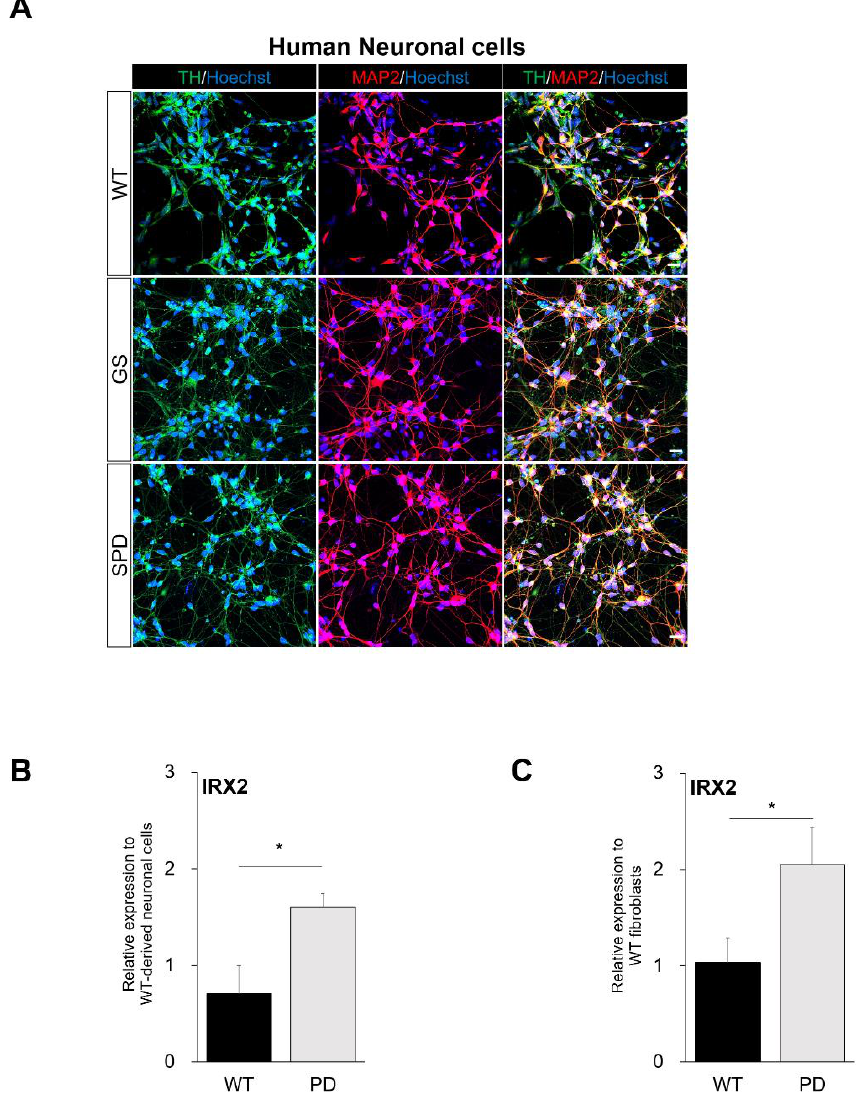
Figure 5. Confirmation of the expression of the newly identified gene, IRX2 , in neuronal cells containing dopaminergic neurons. ( A ) Characterization of neuronal cells containing dopaminergic neurons from healthy control (WT), LRRK2 G2019S familial (GS), and sporadic (SPD) PSCs. The neuronal marker (Microtubule-associatedprotein2; MAP2)andthedopaminergicneuronalmarker(Tyrosinehydroxylase; TH) were co-stained (scale bar 20 µ m). ( B ) Relative expression levels of IRX2 (WT, 0.7100 ± 0.2900, n = 2; PD, 1.598 ± 0.1473, n = 5, p -value 0.0281) in familial / sporadic PD patient-derived neuronal cells containing dopaminergic neurons (PD) in comparison with normal control-derived cells (WT). ( C ) Determination of IRX2 in human fibroblast cells. Examination of IRX2 (WT, 1.033 ± 0.2582, n = 8; PD, 2.047 ± 0.3931, n = 8, p -value 0.0489) expression in familial / sporadic PD patient-derived fibroblast (PD) and healthy control fibroblast (WT) through qRT-PCR analysis. Data are mean ± standard error of means (SEM) of at least three independent experiments. p -values were analyzed using the unpaired two-tailed Student’s t-test (* p <